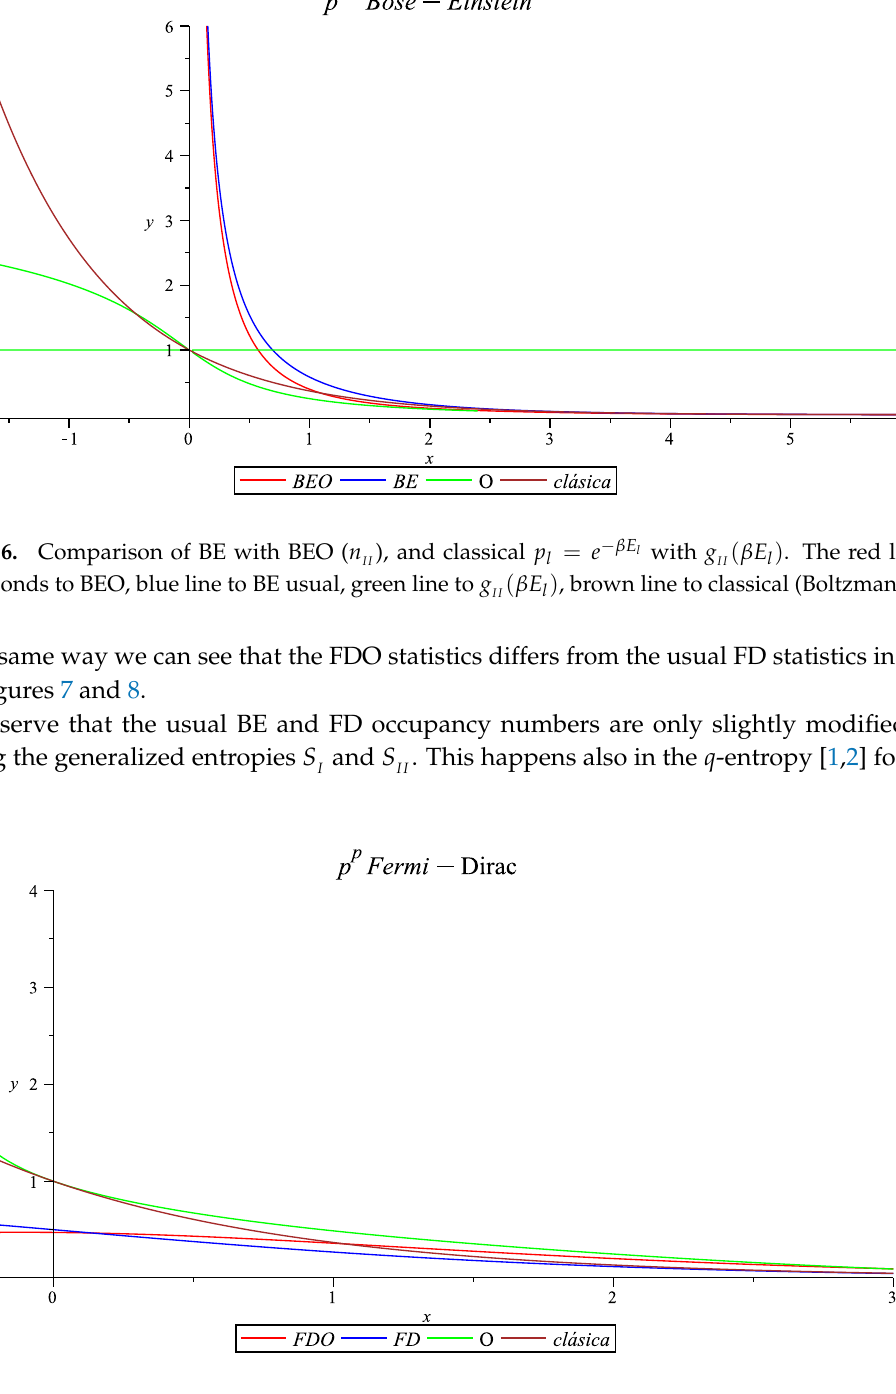
Figure 7. Comparison of FD with FDO ( n corresponds to FDO, blue line to FD usual, green line to g